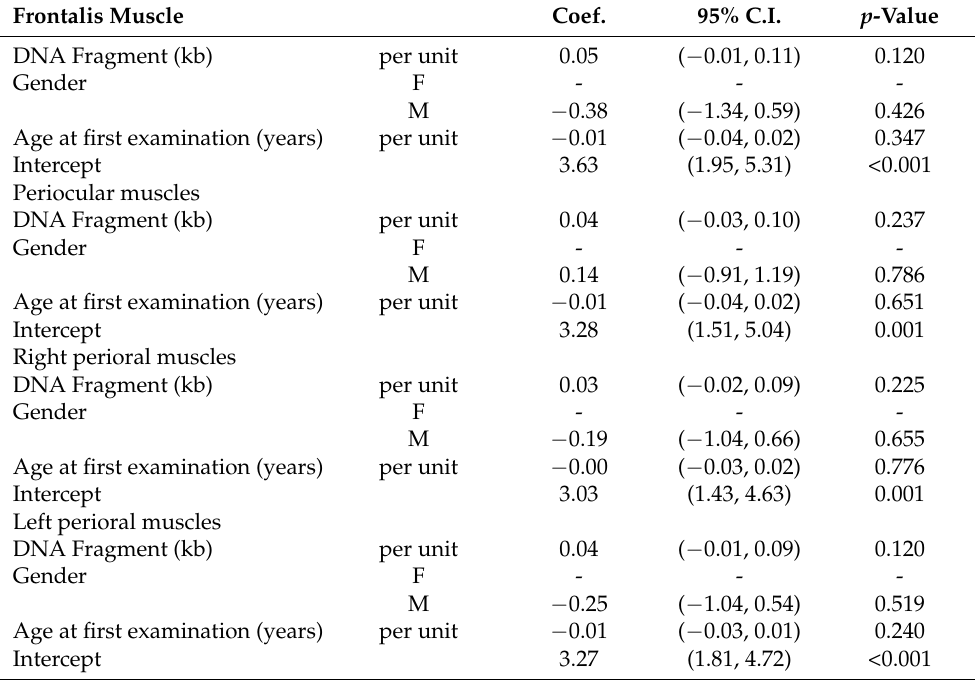
Table 2. Multivariate analysis for the association between DNA Fragment (kb) and frontalis muscle weakness, periocular muscle weakness, right perioral muscle weakness, and left perioral muscles weakness, adjusting for gender and age. Frontalis Muscle Coef. 95%